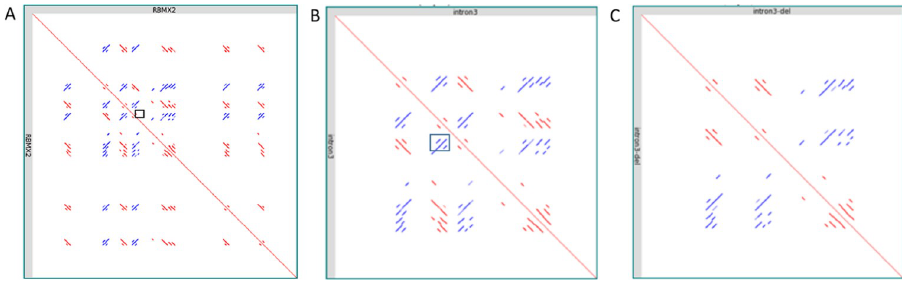
Fig 7. The sequence context of the RBMX2 (11,688bp) gene. (a ) The RBMX2 gene sequence was aligned against itself. The red lines represent sequence homologies between sequences on the same strand, while blue lines represent sequence homologies on the antisense strand. The 330bp Alu element deletion in intron 3 is marked with a black box. ( b ) The intron 3 sequence is aligned in the RBMX2 gene against itself. Again, the 330bp deletion is marked with a black box. ( c ) The 330bp deleted Alu element sequence is aligned against